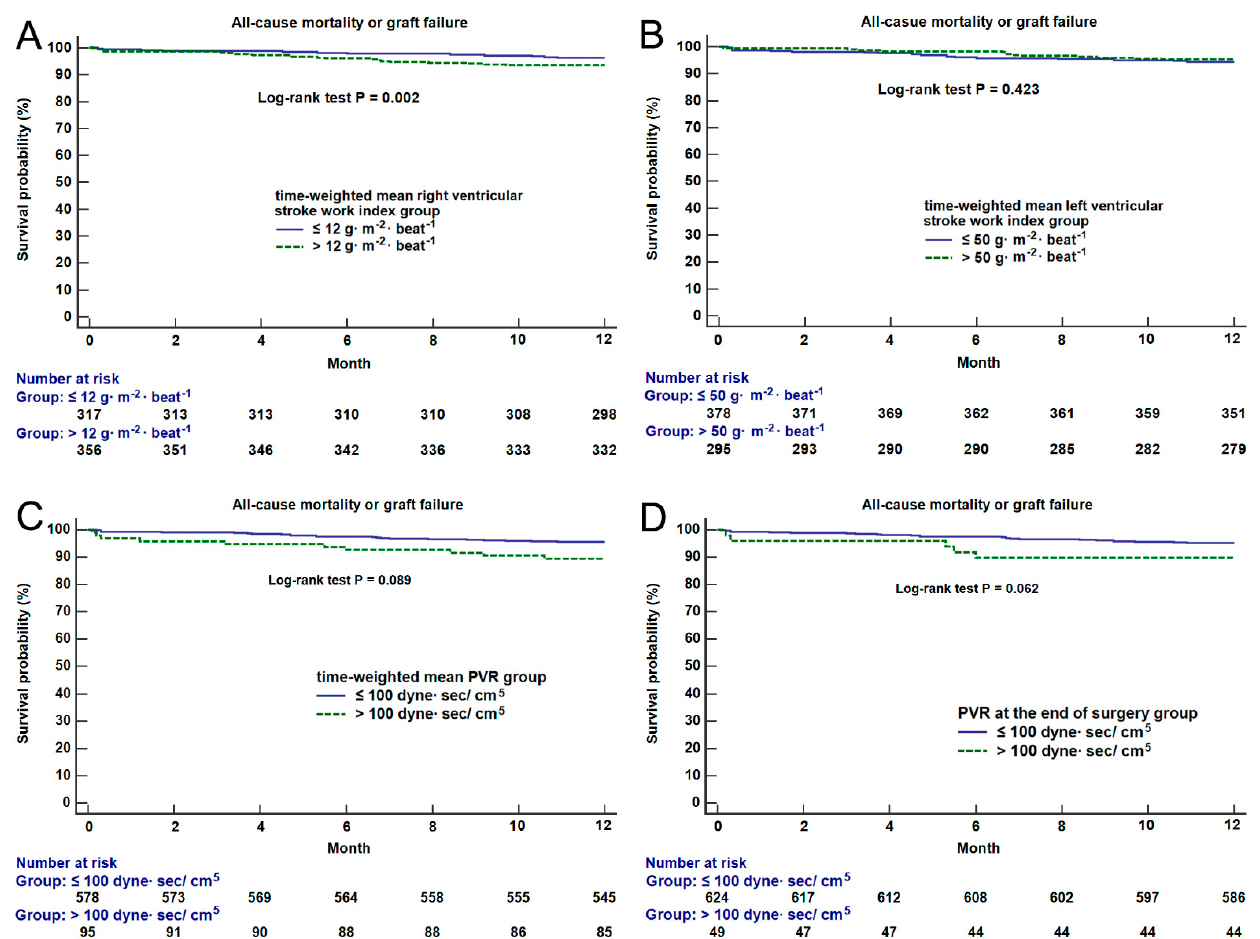
Figure 2. Kaplan–Meier survival curve analysis between intraoperative time-weighted mean right ventricular stroke work index groups ( A ), left ventricular stroke work index groups ( B ), time-weighted mean PVR groups ( C ) and PVR at the end of surgery groups ( D ). The results of log-rank test between the groups are shown on the figure. PVR = pulmonary vascular resistance.